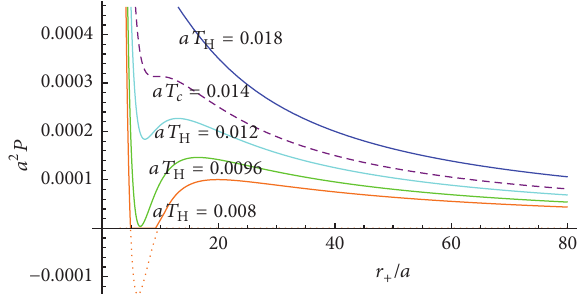
Figure 6: Plot of the equation of state. The solid curves correspond to the cases of 𝑎𝑇 H = 0.018 (blue), 0.012 (cyan), and 0.0096 (green) from top to bottom, respectively. The orange curve corresponds to = 0.008 , but the dotted part, where the pressure is negative, 𝑎𝑇 H does not actually exist. The dashed purple curve corresponds to the critical temperature 𝑎𝑇 𝑐 = 0.014